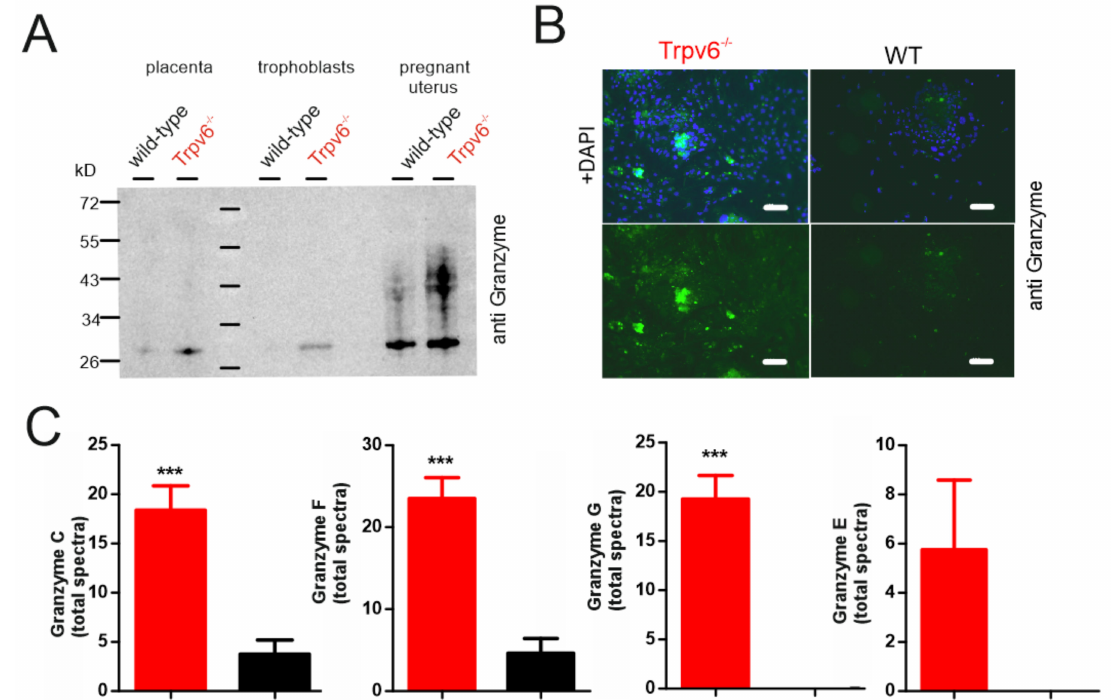
Figure 5. Granzymes are more abundantly expressed in Trpv6 - / - trophoblasts. ( A ) Western blot of protein lysates obtained at day of preparation (day1) from placentae, trophoblasts and pregnant uteri were tested for the presence of granzymes. Equal amounts of proteins, as determined by bicinchoninic acid (BCA) assay were loaded. ( B ) Detection of granzymes in trophoblast cells at day 3 of cell culture, bar = 100 µ m. ( C ) MS / MS-identified spectra of di ff erent granzyme isoforms identified in wild-type and Trpv6 -deficient trophoblasts ( n = 8 lysates / genotype). The significance di ff erence between the groups was calculated using Student’s t -test (*** p <